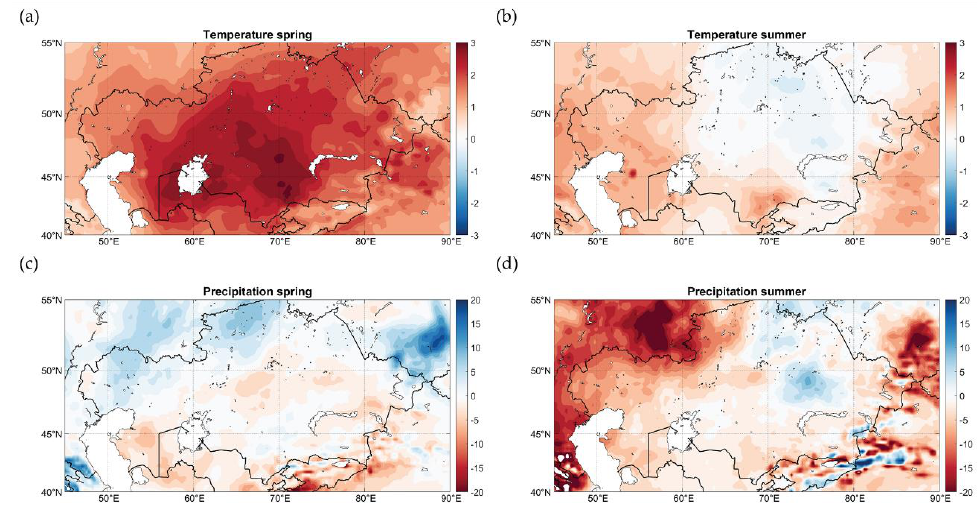
Figure 4. The spatial distributions of the differences between the air temperature at 2 m (upper panel a and b ) and precipitation rate (bottom panel c and d ) averaged over the periods 2001 – 2021 and 1979 – 2000 in the spring (left column a and c ) and summer (right column b and d ) seasons.